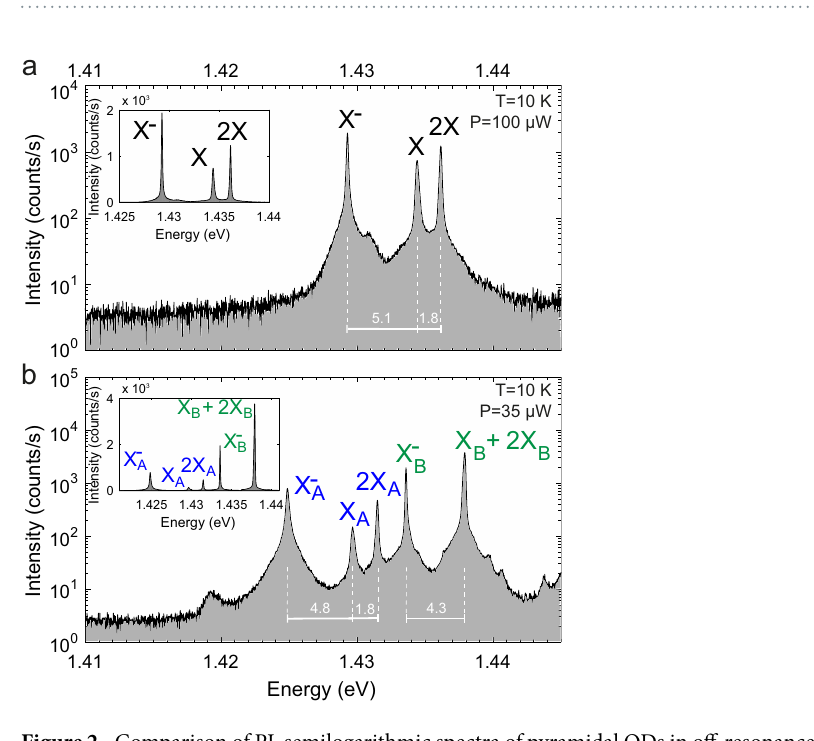
(CM) of the L 3 cavity by varying the sample temperature. All spectral features of the two QD excitons and the cavity mode ( Q = 2200), are unequivocally identified. At 40 K , the neutral exciton X A of dot A and the negatively charged exciton − X of dot B simultanously overlap with the CM. B Evidence for (weak) coupling of both QD excitons to the common CM is presented in Fig. 4a,b, which depicts the measured and modeled (see Supplementary material part A) polarization-resolved PL spectra of the structure, where I V and I H are the spectra resolved in linear polarization along the vertical (V) and horizontal (H) directions indicated in Fig. 1b. The measured spectra focus on the − X and X A features, each spectrum centered at the average B . The CM is resonant with − X at T ~ 20 K and with X A at frequency of these two transitions ω ω ω = + − ( ) /2 B X X 0 A